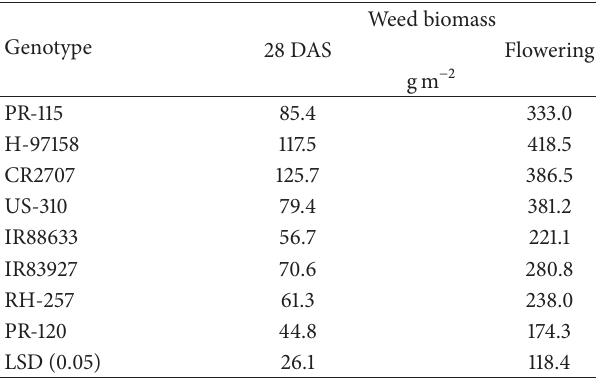
Table 2: Weed biomass (g m −2 ) in response to different genotypes at 28 d after sowing (DAS) and flowering.